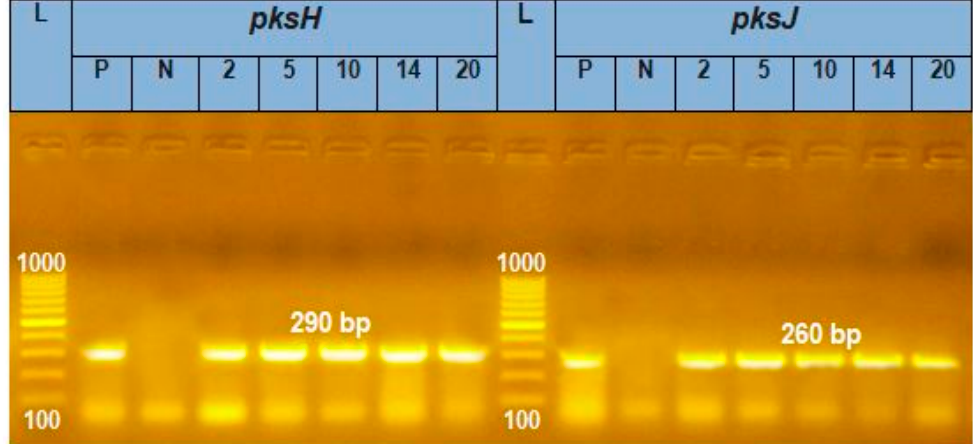
Figure 4. Agarose gel electrophoresis of PCR amplification of pksH (290 bp) and pksJ (260 bp) genes from Alternaria species: L—ladder (100–1000 bp); P—positive control consists of a segment of DNA of known size (the same size as the target amplicon, shows that the primers have attached to the DNA strand); N—negative control: a sample without DNA, but contains all essential components